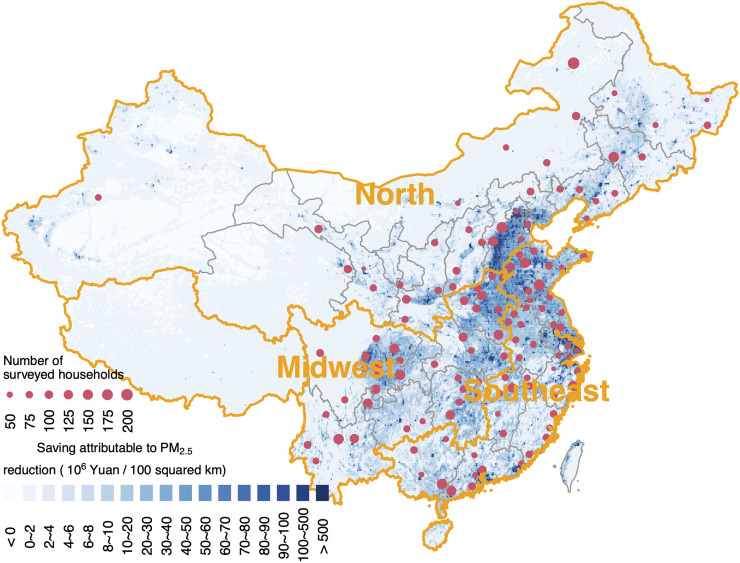
Locations of the surveyed households (red dots).The background colors show the annual savings in medical expenditures attributable to PM2.5, due to air quality improvement from 2013 to 2017. The geographic layers in the map were obtained from Natural Earth (http://www.naturalearthdata.com/). The places without available data (e.g., the South China sea islands) are not displayed in the maps. PM, particulate matter.